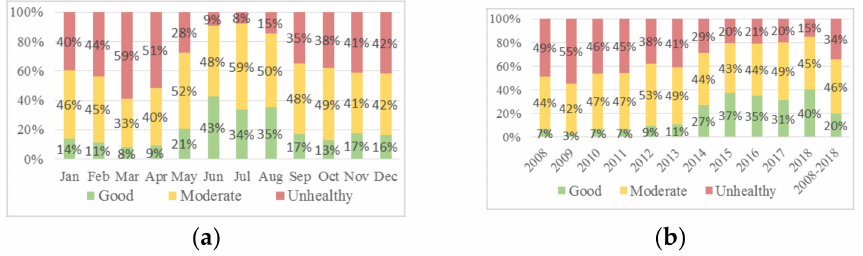
Figure 6. Composition of AQI classes in Changhua: ( a ) Month-based; ( b ) Year-based and Overall-based.